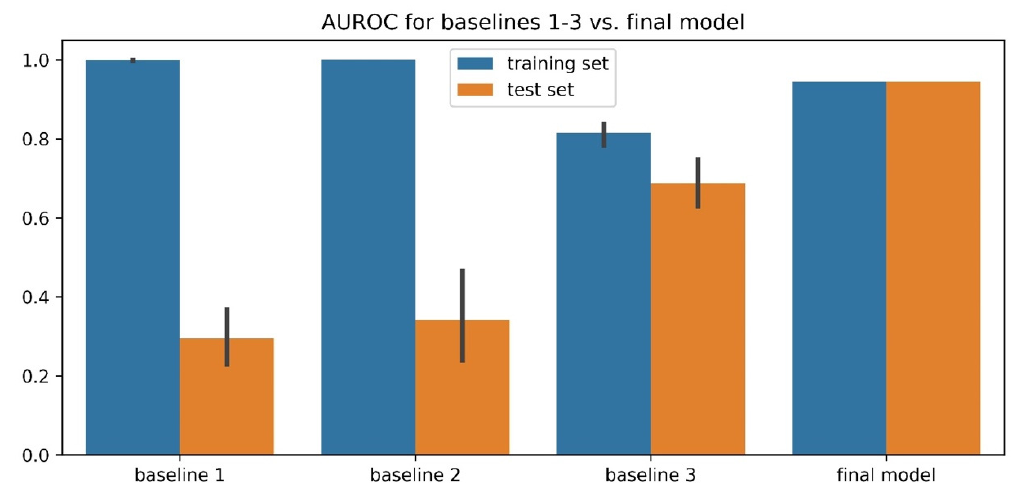
Figure 7. Comparison of three training baselines and the final human + PDB predictor model for validation. Baseline 1 was created by providing random values from a normal distribution N(0, 1) in the weight-training step instead of providing PDB-based physical-feature values to the genetic algorithm. Baseline 2 was created by providing random values from the distribution of residue-specific physical-feature values instead of providing sequence-based physical-feature values. Baseline 3 was created by optimizing 1 weight for 20 residue types for each physical feature (removing residue specificity) during training instead of optimizing 20 weights for 20 residue types for each physical feature.